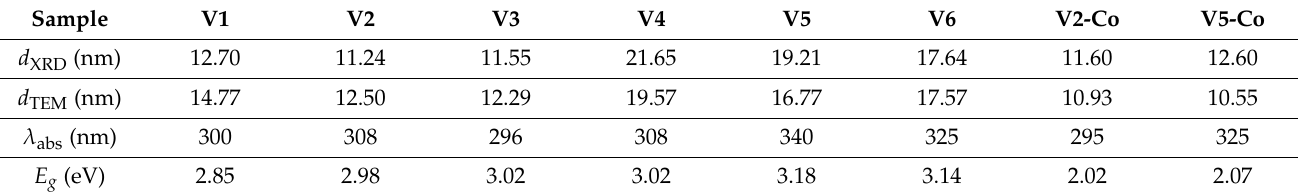
Table 2. Crystallite size (nm), average particle size (TEM, nm), and optical parameters ( λ abs , E g ) of pristine and Co-doped CeO 2 NPs.